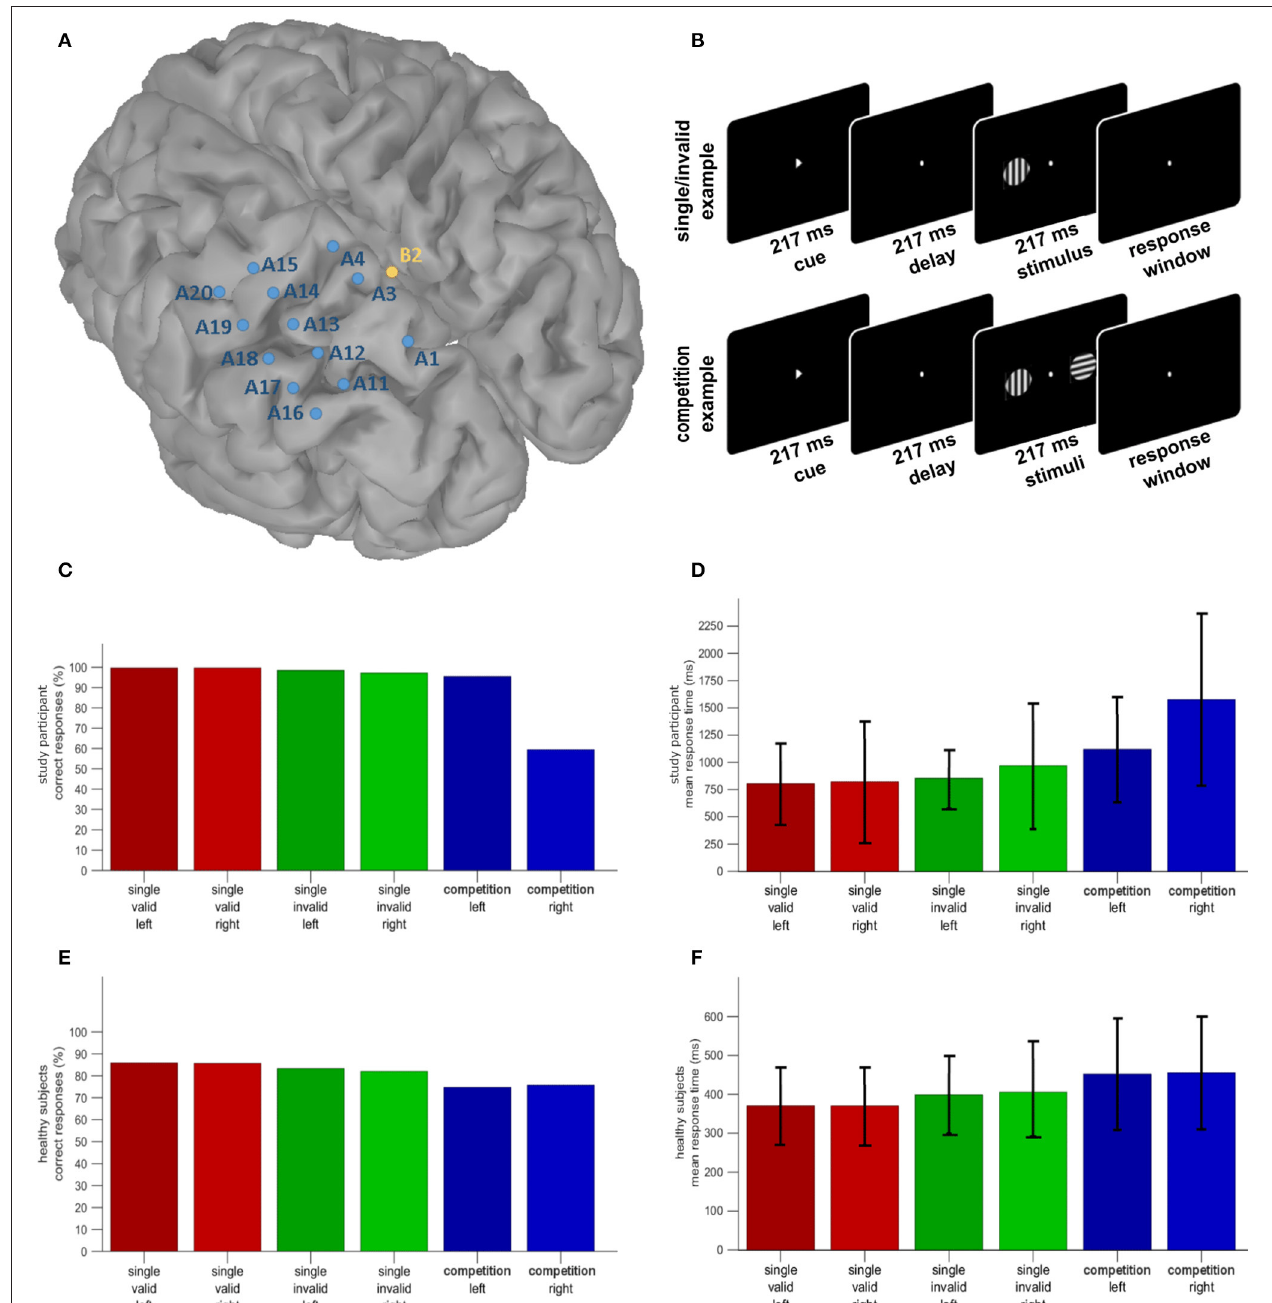
FIGURE 1 | (A) Distribution of the electrode positions on a surface rendering of the patient’s MRI. SPL and the postcentral sulcus are artificially dilated in order to better show the position of the electrodes with respect to these sulci. (B) Hybrid spatial cueing paradigm (Gillebert et al., 2011). (C) Accuracy of the study participant in the different experimental conditions. (D) Reaction times of the study participant in the different experimental conditions (mean and S.D.). (E) Accuracy in the same paradigm in a group of 22 healthy controls. (F) Reaction times in the same paradigm in a group of healthy controls (mean and S.D.). Note that the Y axis differs between the patient and the controls given the overall slower reaction times in the